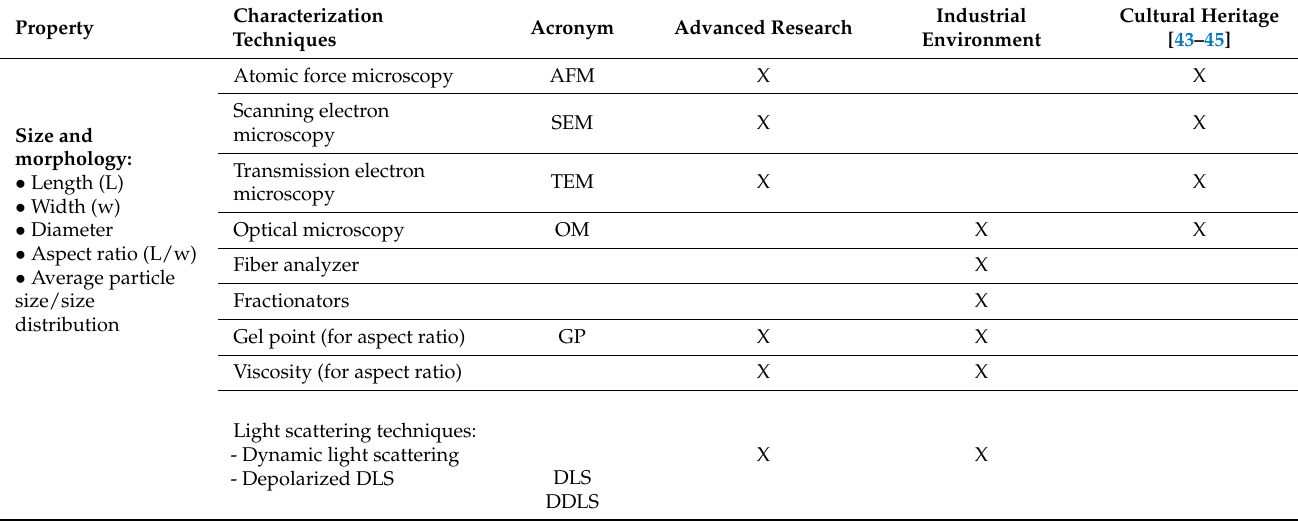
Table 3. Main properties and characterization techniques used for nanocellulose